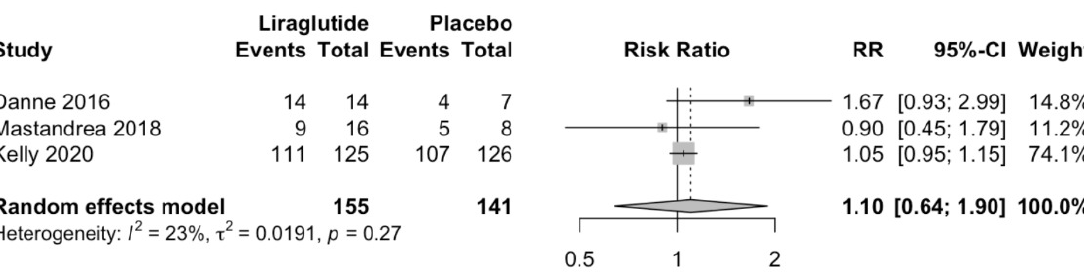
Figure 6. Effect of liraglutide on total adverse effects [5,30,31].